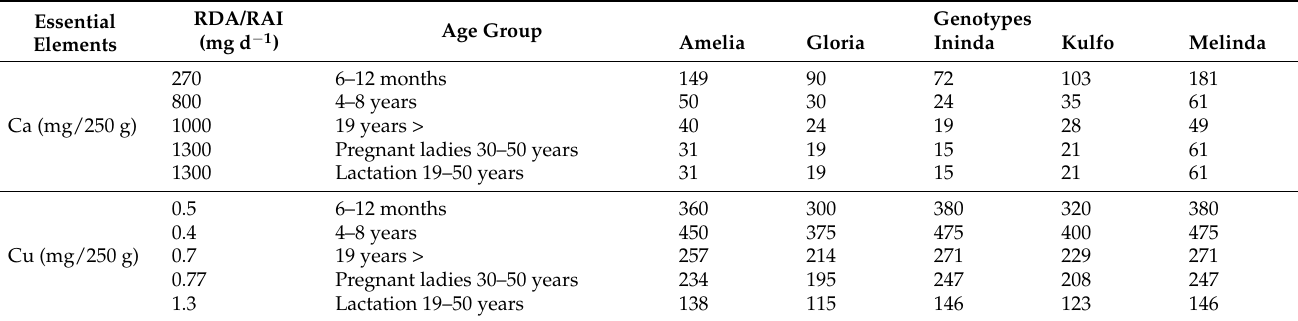
Table 5. Intake of essential mineral elements in OFSP genotypes with a daily dose of 250 g of d.w. of orange flesh sweetpotato per person (70 kg body weight) in the studied